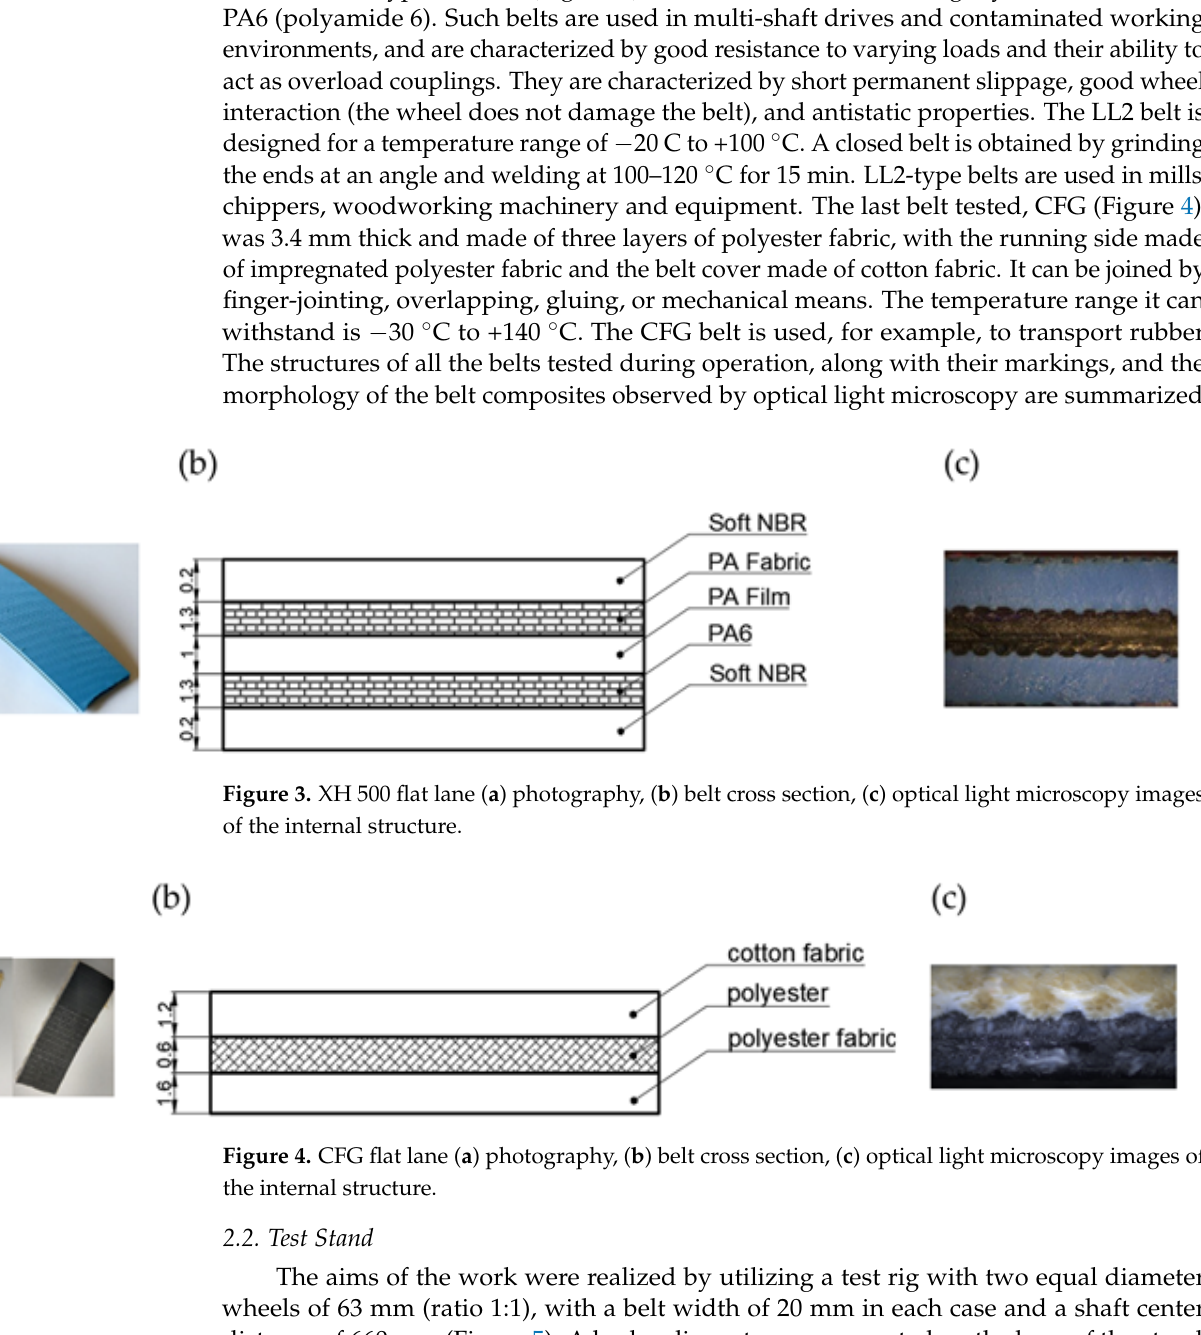
Figure 1. NE22 flat lane ( a ) photography, ( b ) belt cross section, ( c ) optical light microscopy images of the internal structure.